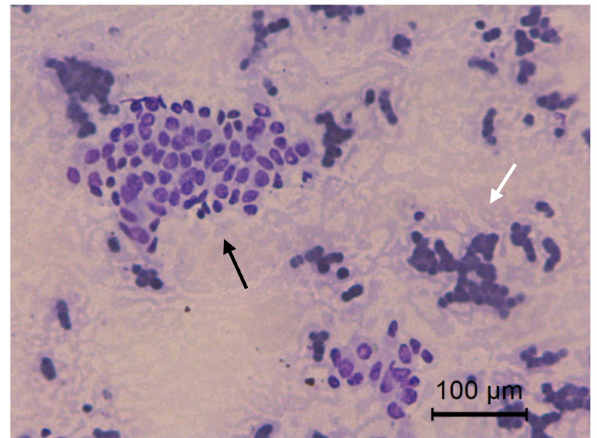
Figure 10. Jenny’s endometrial cytology collected by CB in late diestrus. Cuboidal endometrial cells (black arrow). Dense background and abundant red blood cell (white arrow) present. Modified Wright’s stain 100 × .